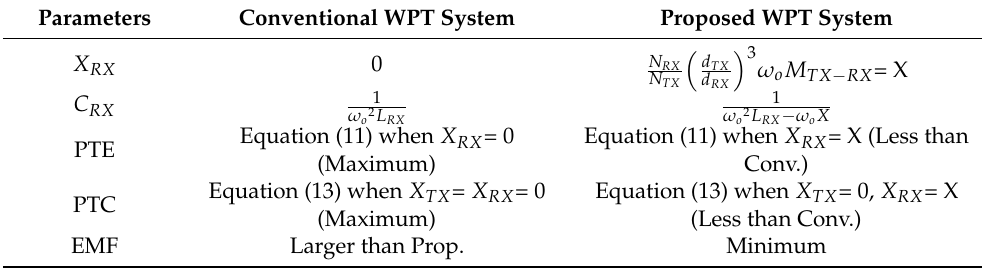
Table 1. Comparison between the conventional and proposed WPT system.